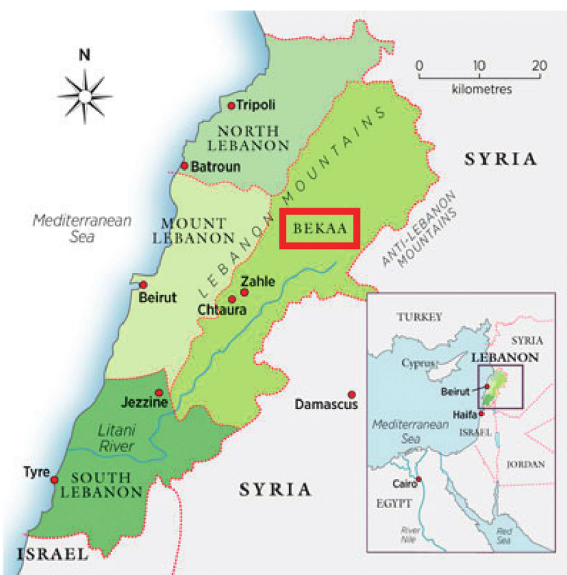
Figure 1: Area of